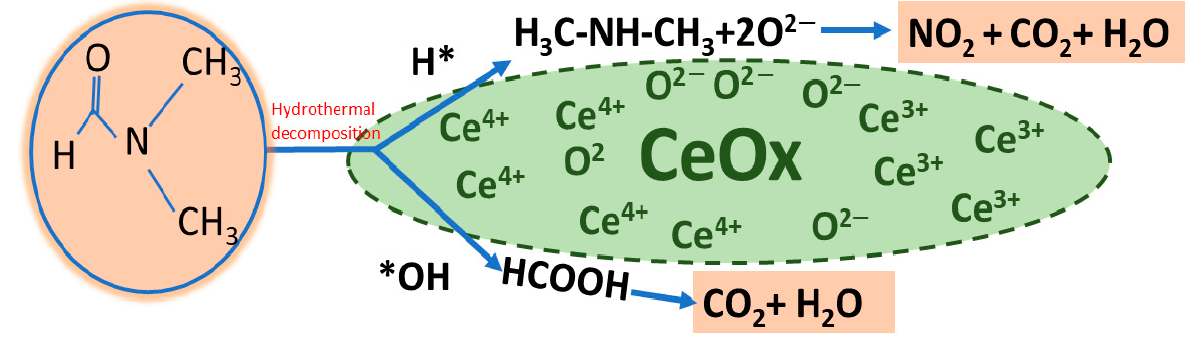
Figure 11. Proposed oxidation pathways of DMF oxidation over supported CeO x catalysts.